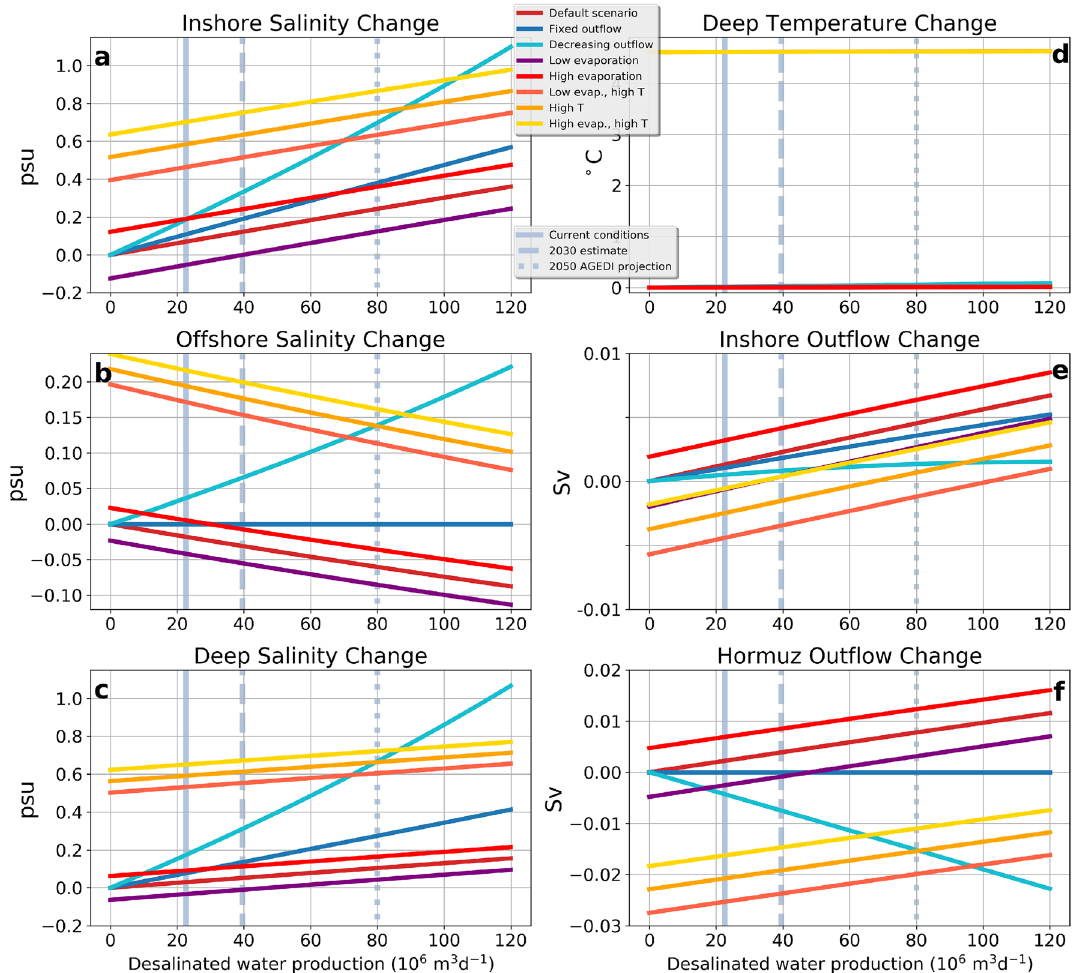
Figure 5. Yearly-averaged changes with respect to the baseline run (present-day climate with no desalination) as a function of the desalination fluxes. The panels show the change in salinity in the inshore ( a ), offshore ( b ) and deep ( c ) boxes. Temperature changes in the deep box are shown in panel ( d ). Panels ( e ) and ( f ) show, respectively, changes in the outflow from the inshore to the deep box and through Hormuz. The vertical gray lines mark the present-day desalination fluxes (continuous), the expected desalination fluxes by 2030 (dashed) and AGEDI’s projected desalination fluxes in 2050